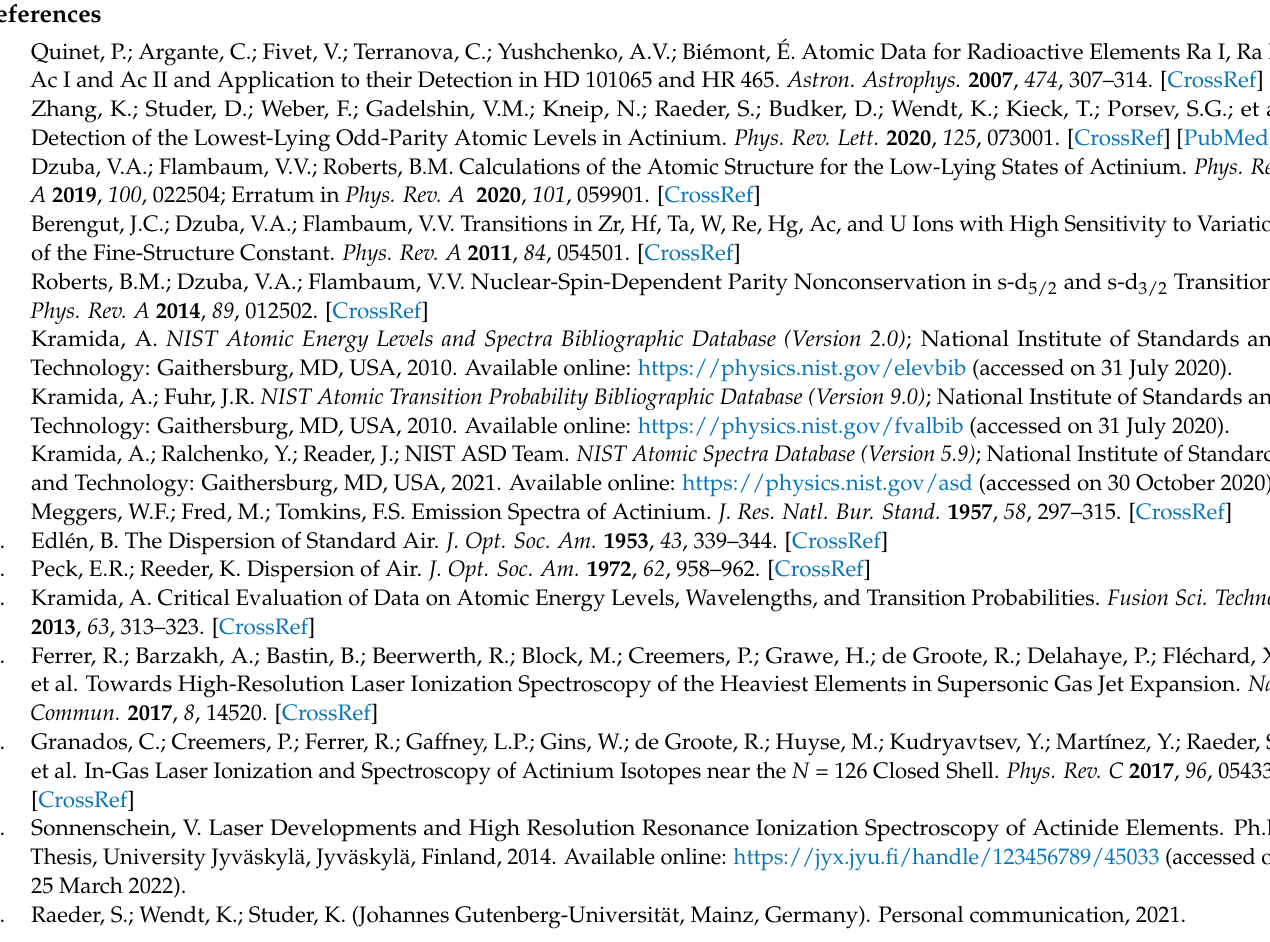
Table S3: Update of Atomic Data for the First Three Spectra of Actinium; Table S4: Update of Atomic Data for the First Three Spectra of Actinium; Table S5: Update of Atomic Data for the First